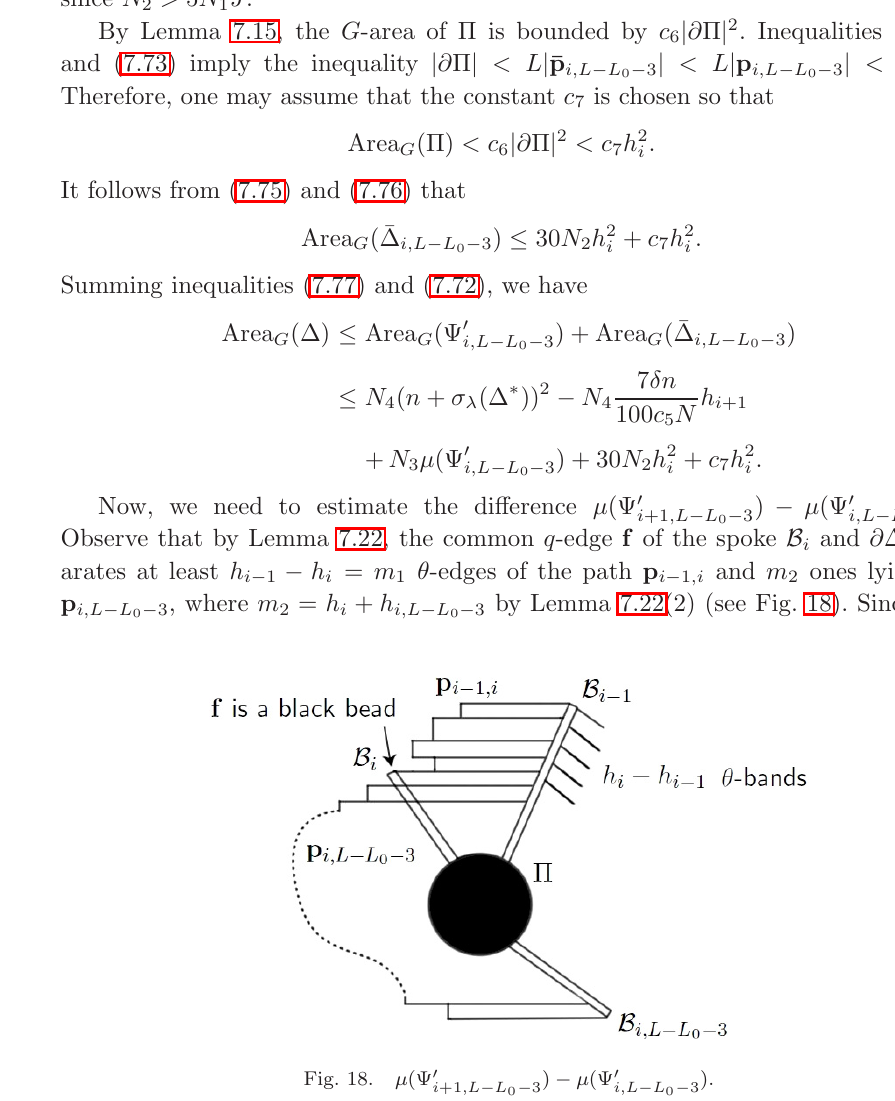
) − μ (Ψ (cid:2) i,L − L 0 − 3